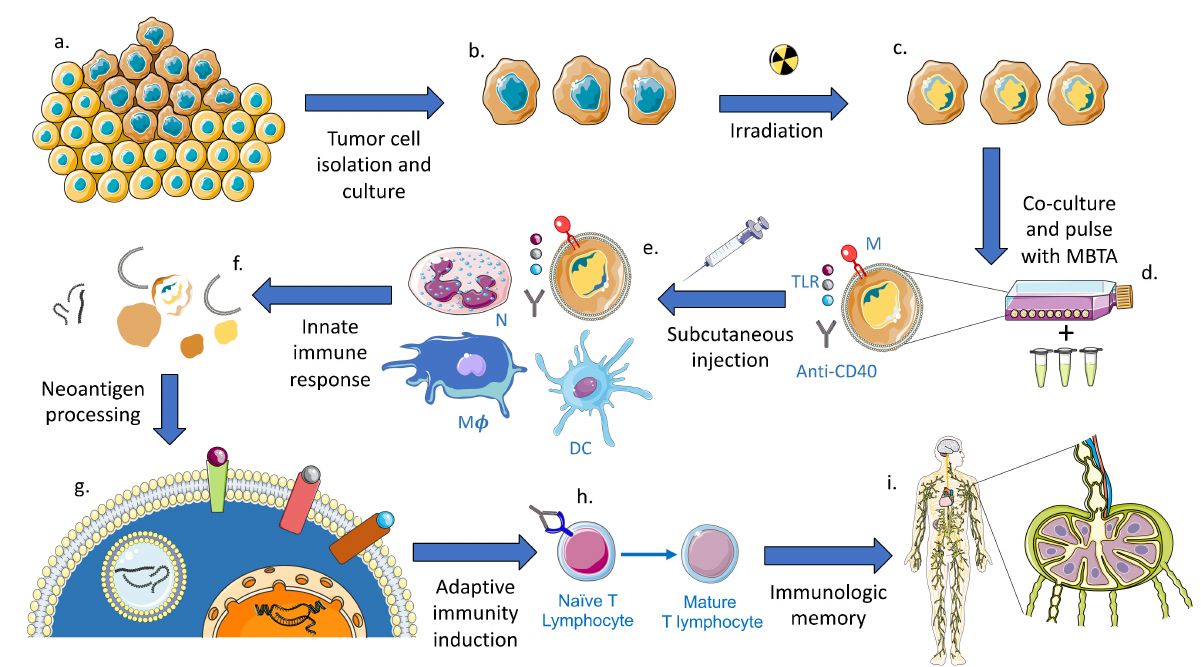
Figure 1. Shown is the mechanism of action for MBTA vaccine therapy. ( a , b ) Patient tumor tissue is isolated and expanded through cell culture for irridation ( c ). The irradiated tumor cells are then ( d ) co-cultured and pulsed with Mannan-BAM (M), TLR Ligands (TLR), and Anti-CD40 Antibody (MBTA). Following MBTA pulse, the co-cultured, irradiated tumor cells are injected subcutaneously into a remote peripheral site ( e ). A local innate inflammatory respond is initiated and results in the recruitment of innate effector cells, such as neutrophils (N), macrophages (M φ ), and dendritic cells (DC). Formation of the inflammasome and destruction of the irradiated tumor cell ( f ) leads to release of native immunogenic neoantigens for ( g ) processing by antigen presenting cells (APCs). This leads to induction of adaptive immunity ( h ) and generation of memory anti-tumor response ( i